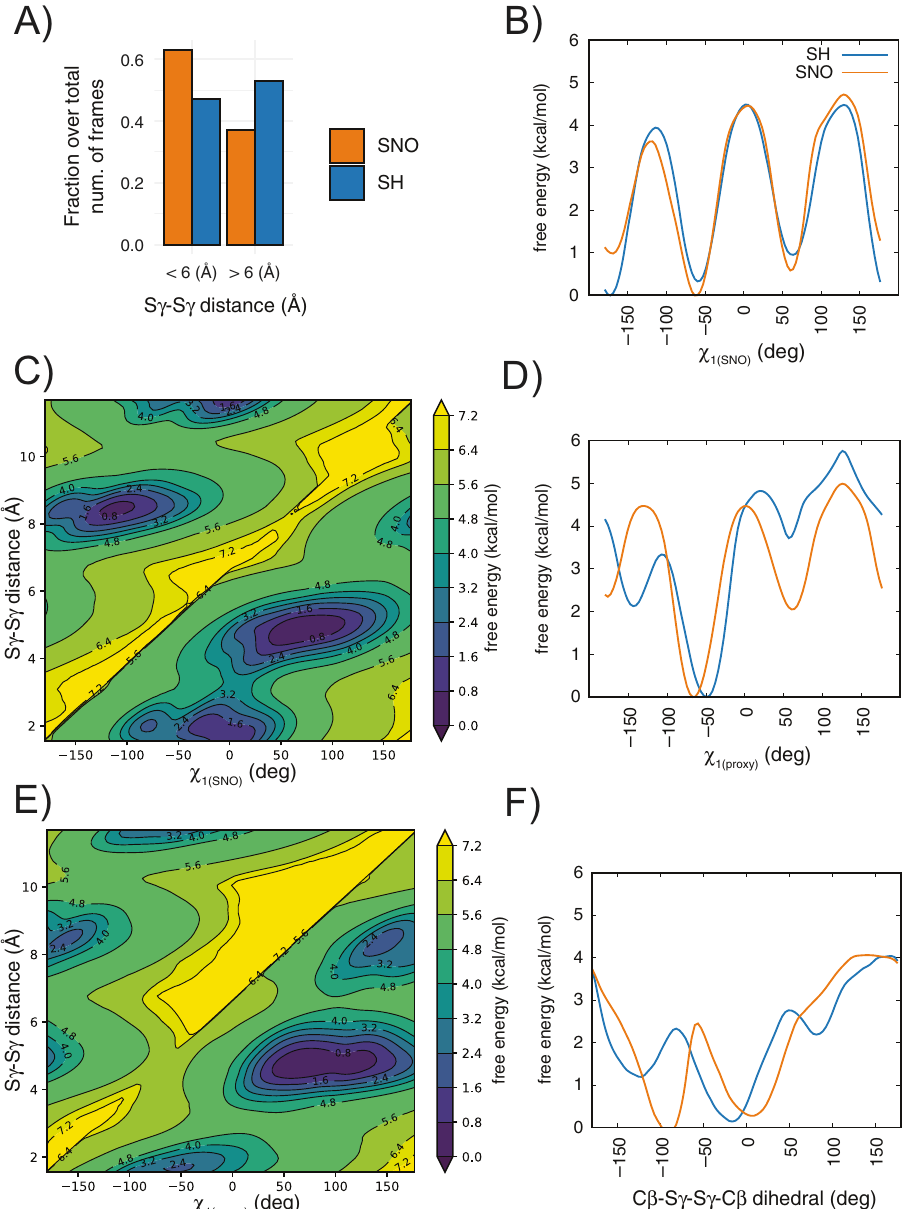
Fig. 3 S -nitrosylation of C516 of TRAP1 favors conformations more suited to the disul fi de-bridge formation with the proximal cysteine. We performed metadynamics of the reduced (SH, blue) and S -nitrosylated (SNO, orange) variants at the C516 site of Danio Rerio TRAP1 311 – 567 using ff99SB*-ILDN force fi eld. A The bar plot shows the fraction over the total number of frames of the metadynamics trajectories with S γ -S γ distance values lower/higher than 6 Å. We observed a higher propensity towards lower distances between the two cysteines upon S- nitrosylation of C516. B – F Mono- and bi-dimensional free energy surfaces associated with the collective variables for the metadynamics simulations: B χ 1(SNO) , C χ 1(SNO) and S γ -S γ distance, D χ 1(proxy) , E χ 1(proxy) and S γ -S γ distance, F C β -S γ -S γ -C β . We observed that the S -nitrosylation of C516 disfavors the trans states of χ 1(SNO) of around 1 kcal/mol (panel A). The S -nitrosylation of C516 disfavors the trans states of χ 1(proxy) of more than 2 kcal/mol and makes more favorable the plus states of χ 1(proxy) (panel D ). The plus and minus states of χ 1(SNO) and χ 1(proxy) correlate with S γ -S γ distances lower than 6 Å between the two cysteines (panels C and E ). S -nitrosylation favors a conformation for the C β -S γ -S γ -C β dihedral angle around − 90 degrees which is often observed in disul fi de bonds (panel F solvent accessible and could represent more reliable hits as 1477 cases of a SNO site with a proximal cysteine according to the candidates for modi fi cations by NO. Most sites are also located in distance criteria in 631 proteins. Of these, only 489 sites featured regions classi fi ed as having a con fi dent prediction in the accessibility of the cysteine side chain higher than 10% (Fig. 5B). The remaining SNO sites were rather buried. Buried PTM sites could become available for their modifying enzymes thanks to conforma- tional dynamics, as observed, for example, for phosphorylation [32, 33]. However, SNO fi nder does not consider protein dynamics. Therefore, we decided to focus on sites that are at least partially